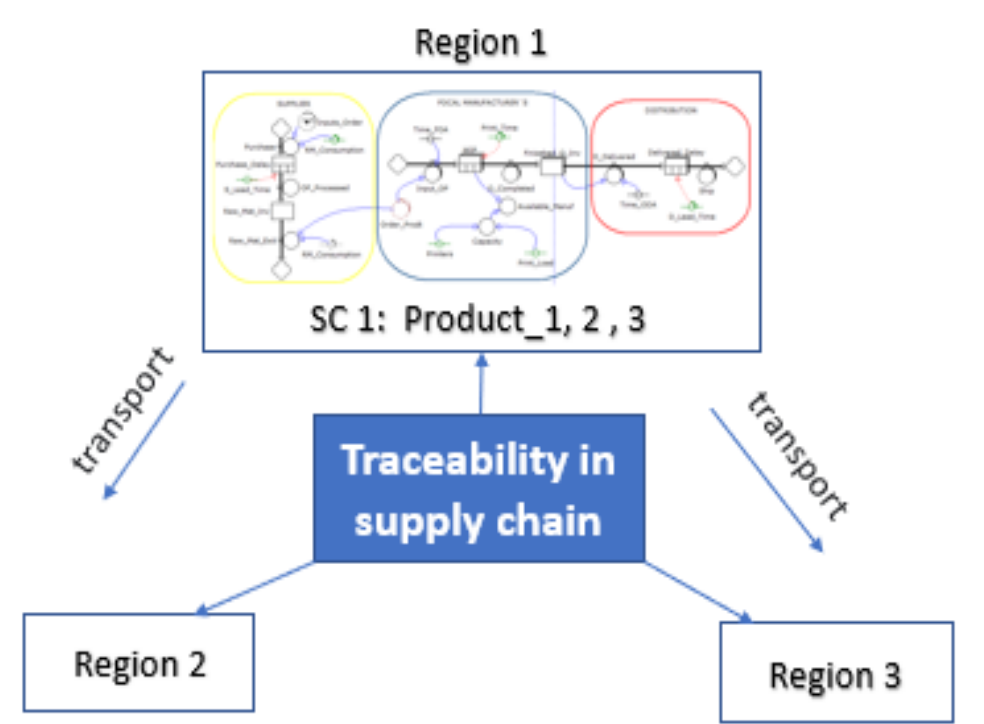
Figure 9. Scenario 2 representation—a centralized additive supply chain. Source: own elaboration. Figure 10. Scenario 2 representation — a centralized additive supply chain. Source: own elaboration.